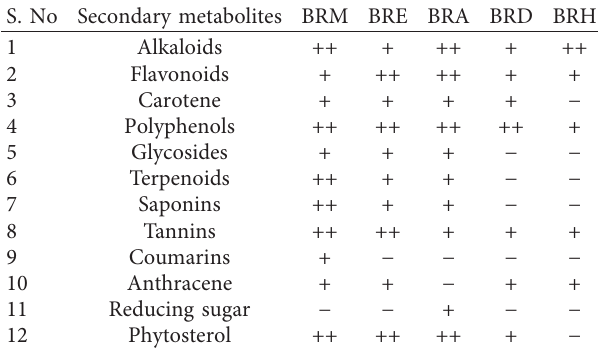
Table 2: Results of phytochemical